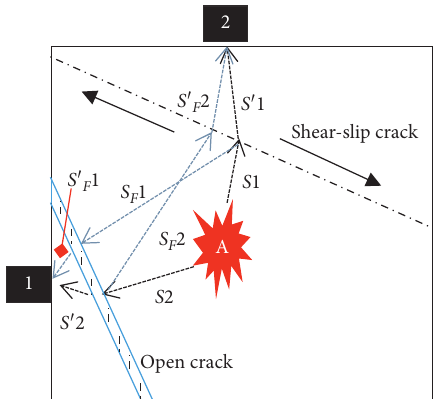
Figure 3: Schematic diagram of the influence of anisotropy on AE signal